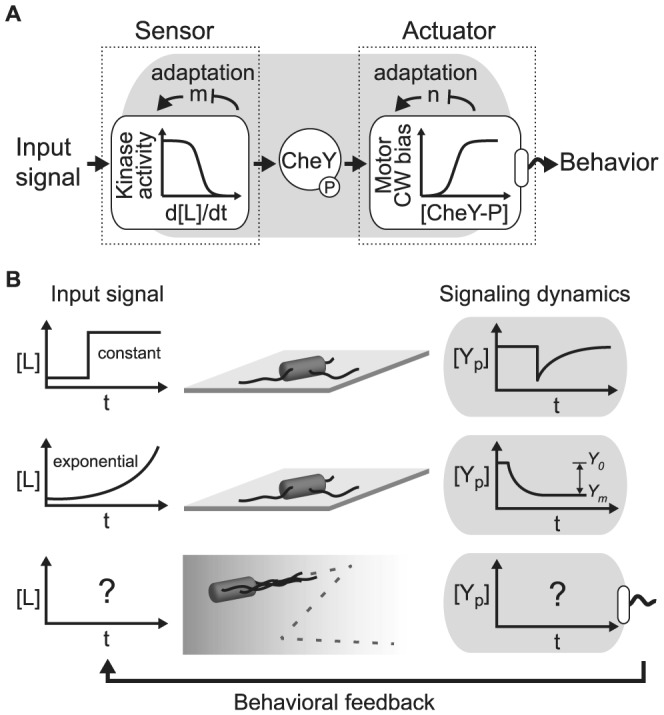
Dynamical coupling between the sensor and the actuator in the bacterial chemotaxis system.
A. The bacterial chemotaxis system is composed of a sensor module (receptor-kinase complexes) and an actuator module (flagellar motors) coupled through the phosphorylated form of CheY. Both modules are ultra-sensitive and adapt to their respective input signals. Maintaining the output of the sensor within the right range relative to the actuator is critical for chemotaxis performance. B. Diagrams of the CheY-P concentration response to different signals. First line: when cells are immobilized onto a slide, a step stimulus of attractant (e.g. methylaspartate) causes a sudden decrease in CheY-P concentration followed by a slower adaptation. Because of the negative integral feedback architecture of the sensor module, CheY-P adapts back to its pre-stimulus level, the adapted CheY-P concentration, Y0. Second line: when immobilized cells are exposed to an exponential ramp in time of the same stimulus, the system, which is log sensing, experiences a constant “force” and adapts towards an operational CheY-P concentration, Ym, lower than the adapted level Y0. This deviation of CheY-P activity from Y0 to Ym changes the coupling between sensor and actuator. Third line: when cells are swimming in a gradient of attractant, their biased random walk causes them to climb the gradient. The average drift velocity of the cell up a chemical gradient affects the average input signal experienced by the cell. This creates a feedback of the behavior onto the input signal, which in turn can significantly affect the operating concentration of CheY-P and thus the coupling between sensor and actuator.